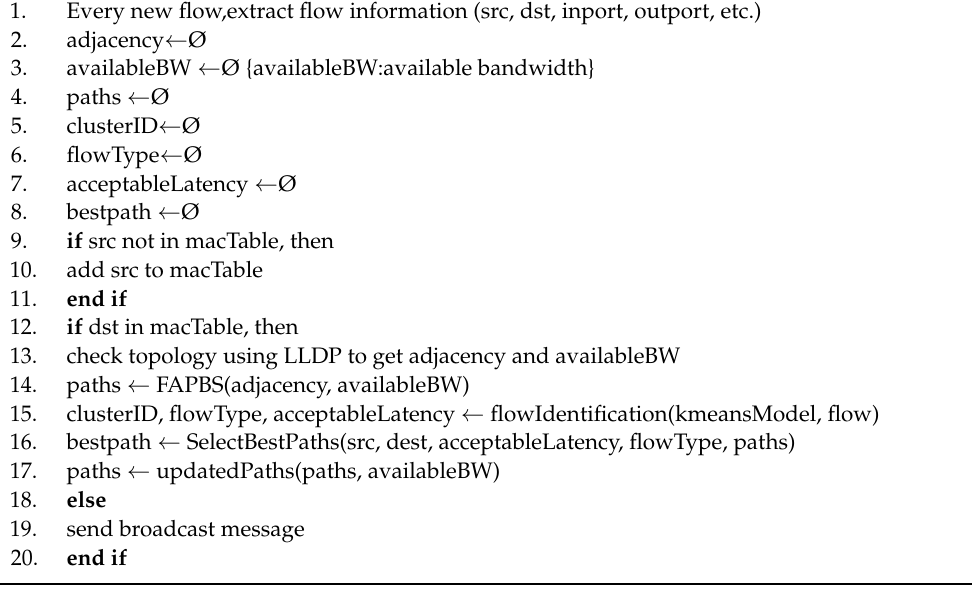
Algorithm 1 Algorithm for routing a flow